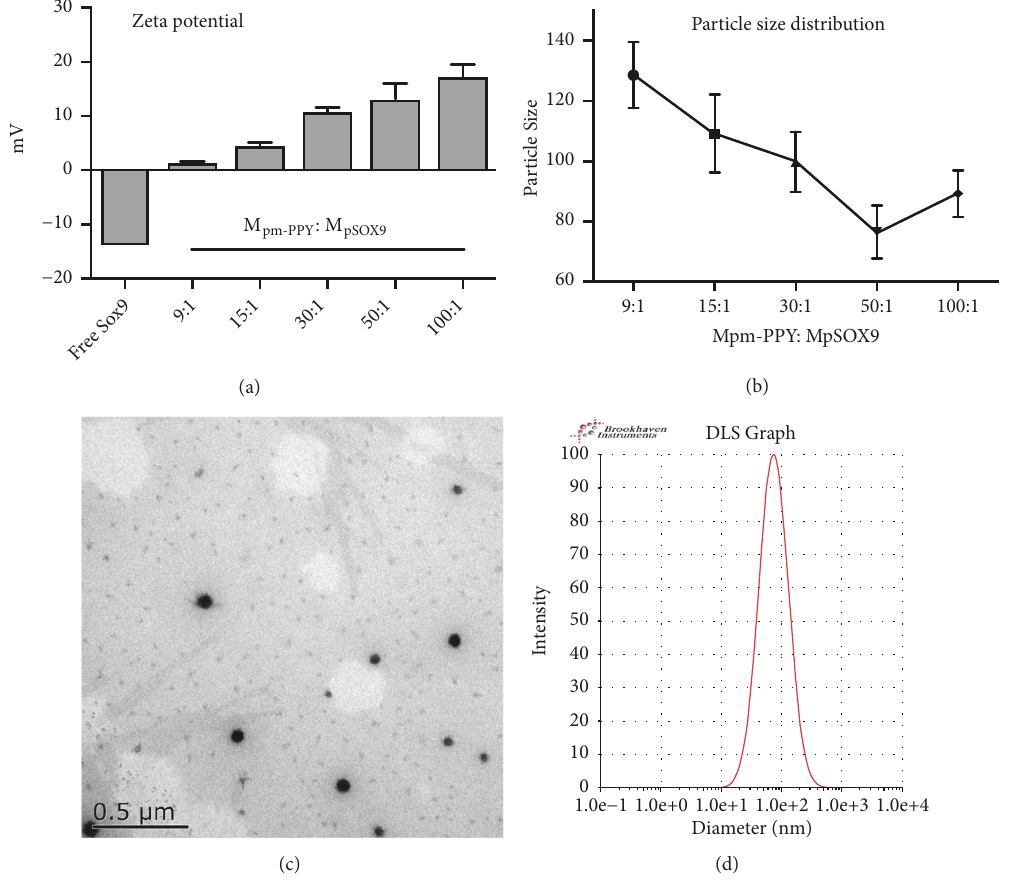
Figure 3: Characterizationsof pmPPY/pSox9 nanoparticles. Notes. (a) Zeta-potential measurement,Lane1: Lipofectamine 2000-pSox9; Lane (2-6):pSox9/pmPPYnanoparticlesinratiosof9:1,15:1,30:1,50:1,and100:1;(b)particlesizedistribution;(c)TransmissionElectronMicroscope (TEM) image of pmPPY/pSox9 nanoparticles (50:1) (scale length: 500 nm); (d) dynamic light scattering (DLS) analysis of pmPPY/pSox9 nanoparticles